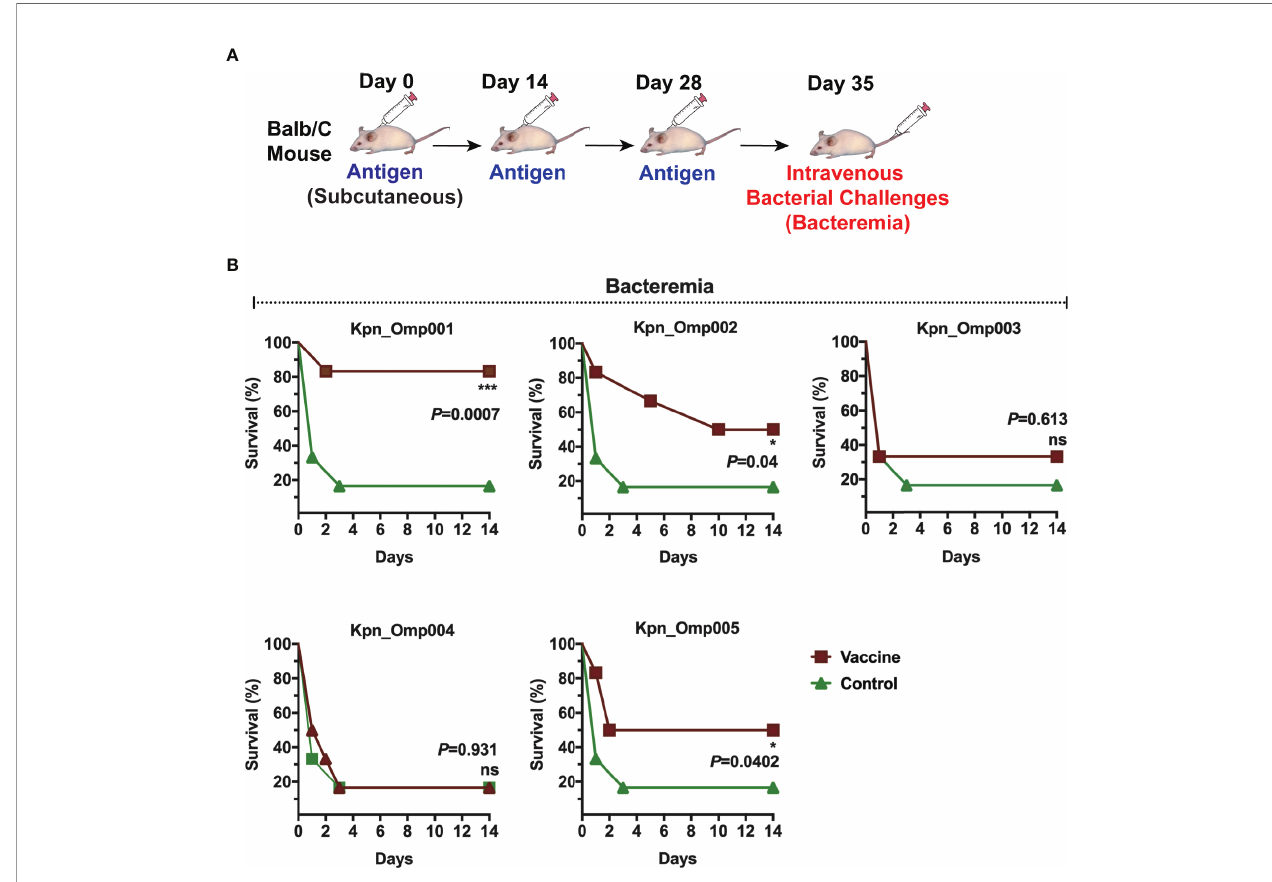
FIGURE 3 | Murine bacteremia model. (A) Balb/c mice were immunized with the KOMPs individually or PBS. Seven days after the second booster vaccination, different doses of K pneumoniae 260 in 100 m l of PBS were injected intravenously into mice. (B) The survival rate of murine bacteremia model was observed every 12 h for 14 days. *p < 0.05, ***p < 0.001. ns, p >